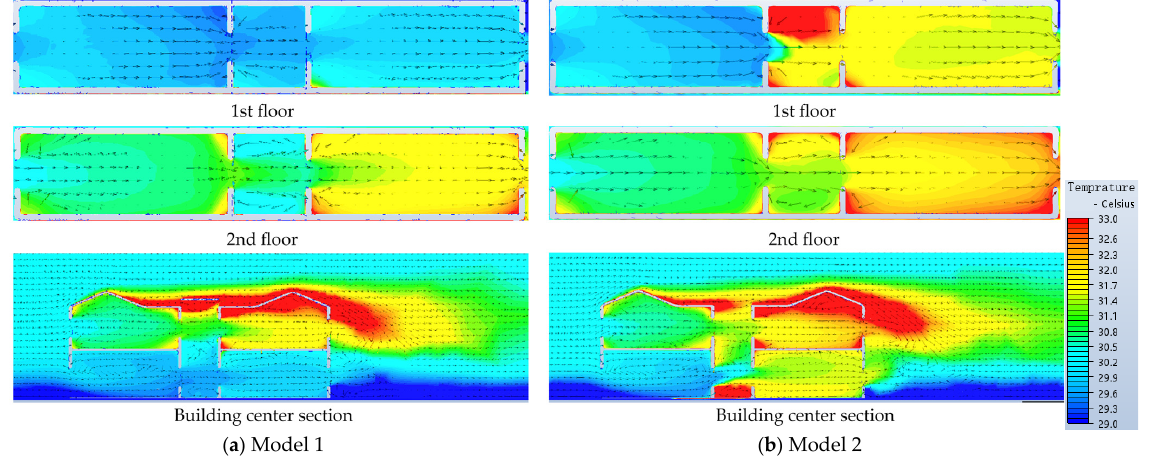
Figure 7. Simulated spatial distributions of T a in Models 1–2 at 12:00 at 1.2 m height on each floor.